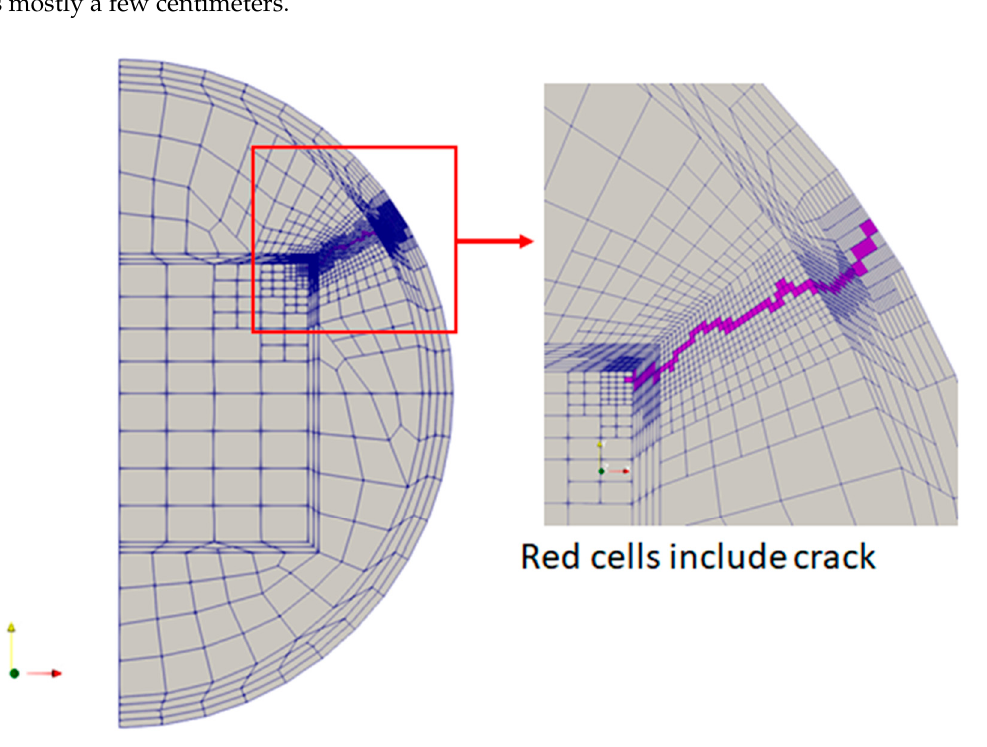
Table 4. Summary of crack parameters passed to GARFIELD-CHEM following the DEAFRAP and FEMWATER analysis. Piecewise linear pathway based on Figure 14.